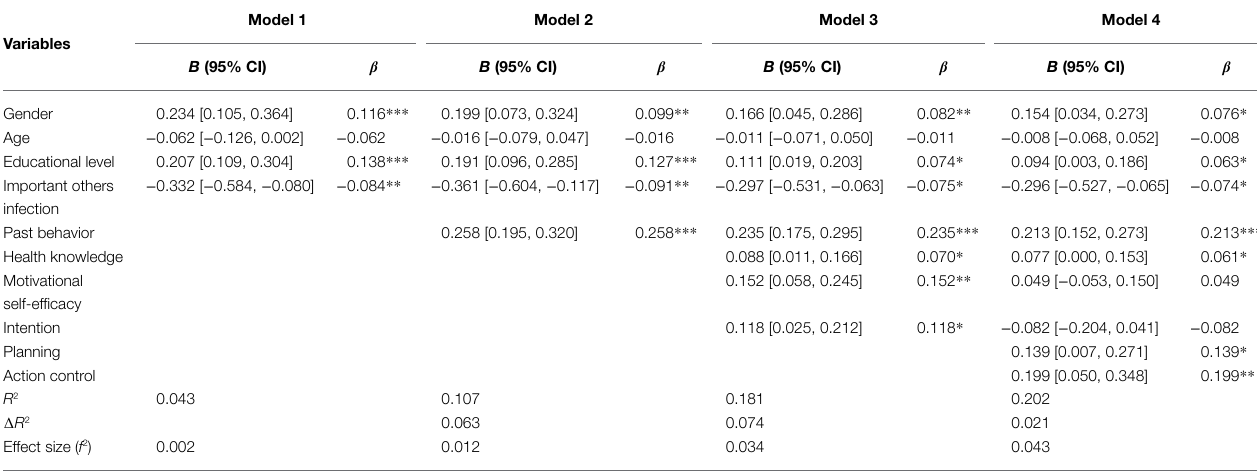
TABLE 5 | Hierarchical regression analysis with mask wearing behavior ( N =